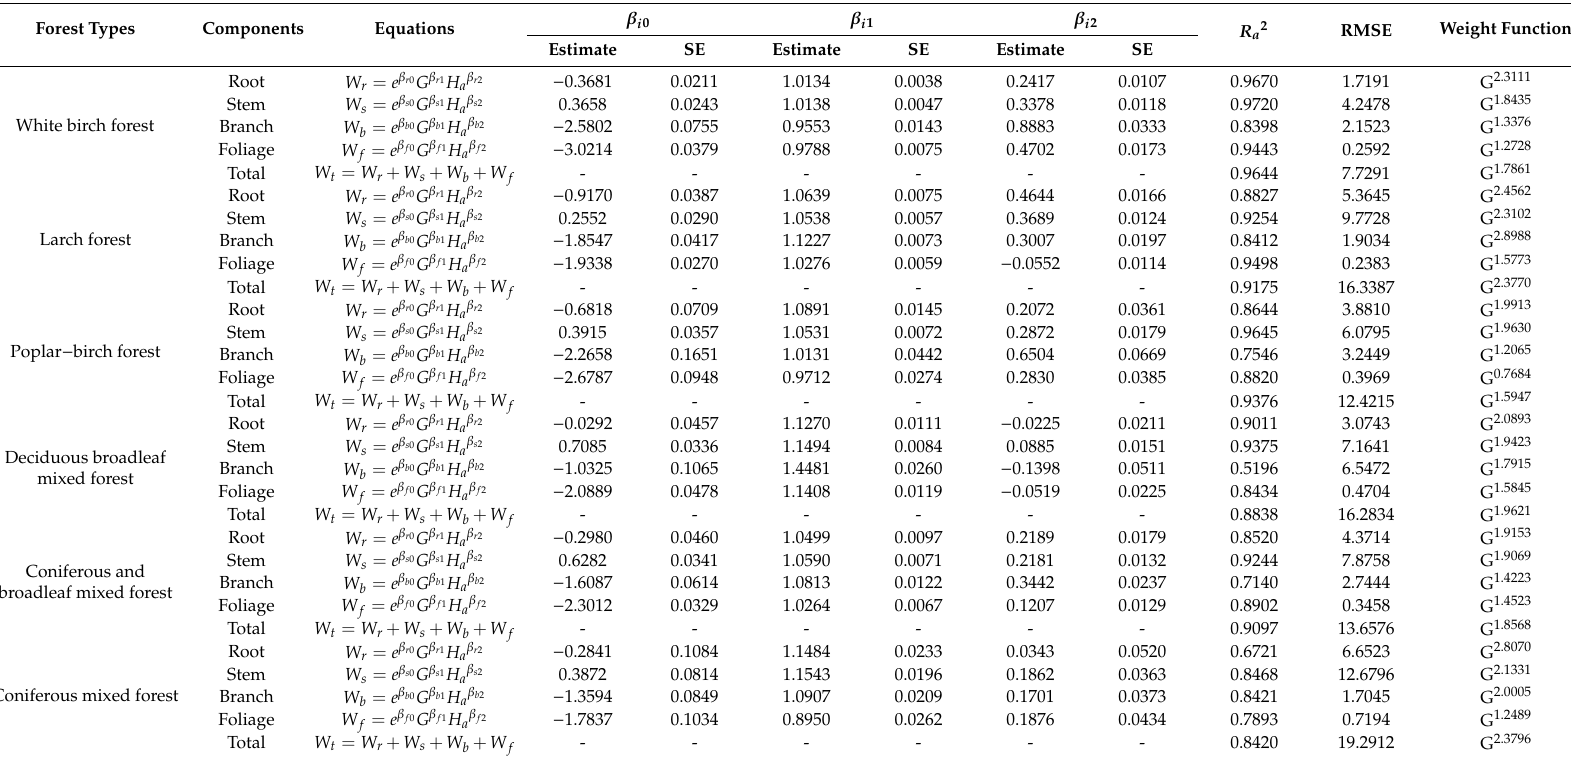
Table 3. Model coe ffi cient estimates, standard errors (SEs), model fitting statistics, and weight functions for the additive system of stand biomass equations using stand variables (namely, M-1) for the six forest types in the Eastern Da Xing’an Mountains, Northeast